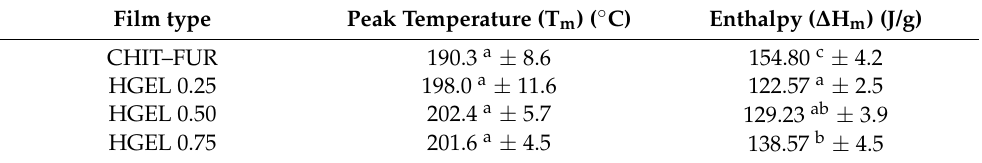
Table 1. Thermal properties of films CHIT–FUR and with addition of the